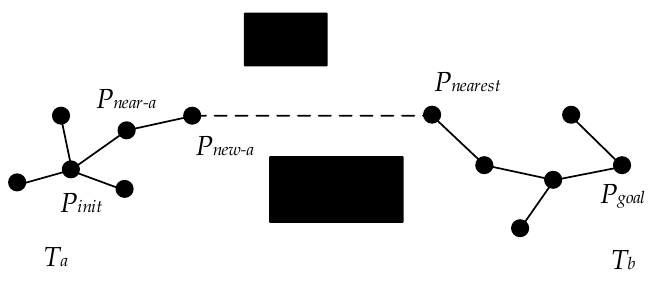
Figure 5. Obstacle-free direct connection of two random